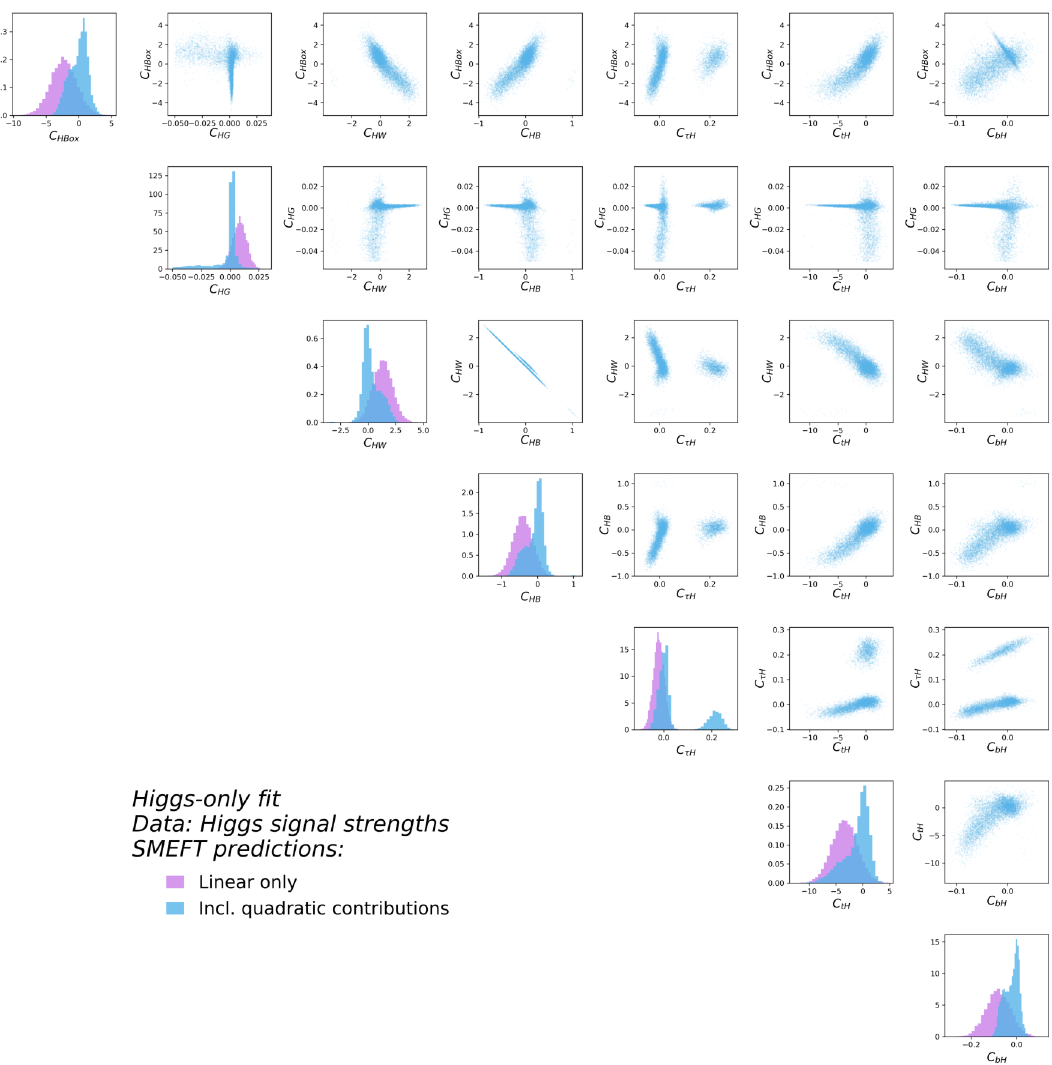
Figure 20 . Samples produced by nested sampling, projected onto 2- and 1-dimensional subspaces of the 7-dimensional parameter space. Along the diagonal we compare the distributions found with and without quadratic SMEFT contributions in blue and purple,